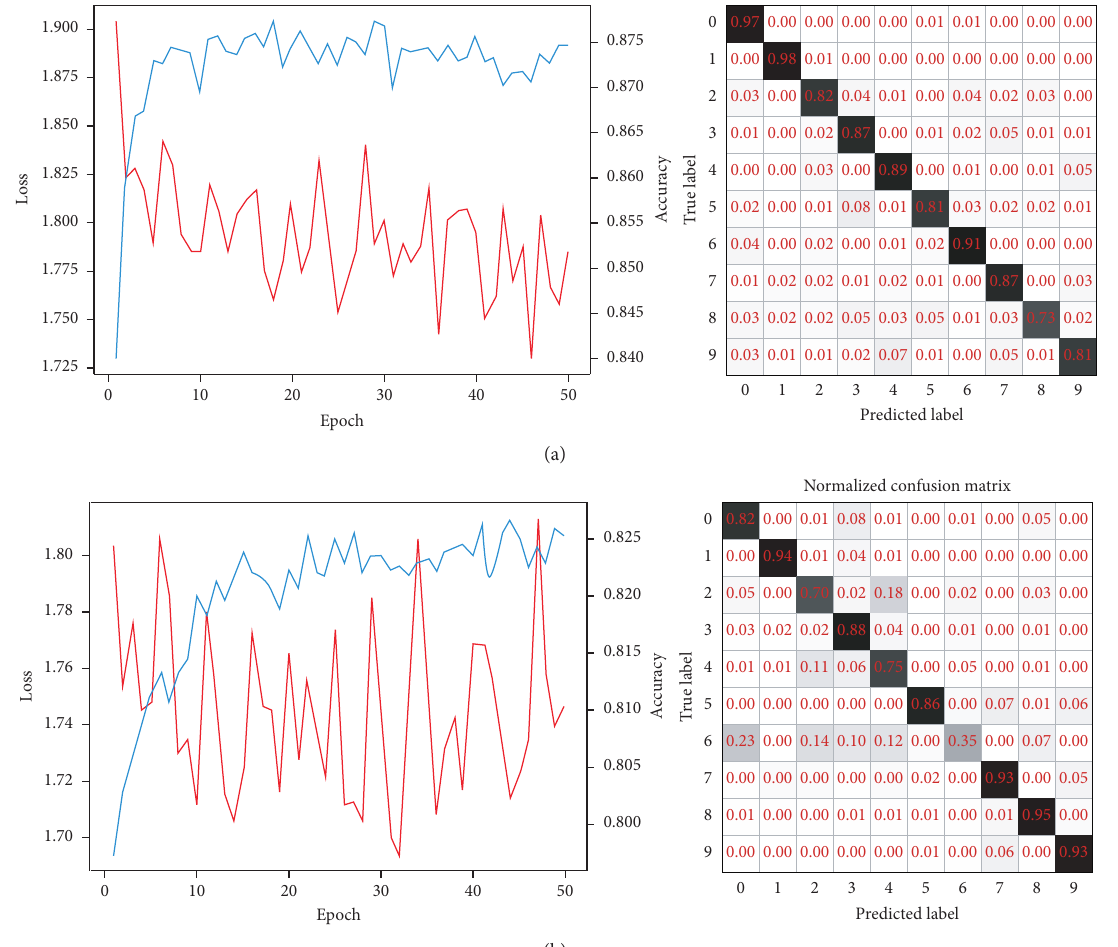
Figure 8: (a) Accuracy rate and confusion matrix of the standard all-optical diffraction deep neural network for the MNIST dataset. (b) Accuracy rate and confusion matrix of the standard all-optical diffraction deep neural network for the Fashion-MNIST dataset.